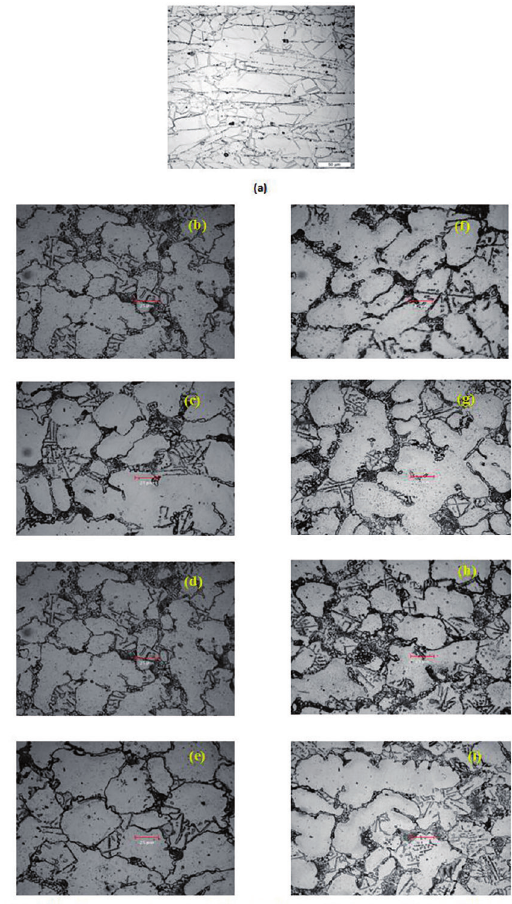
Figure 5. Microstructure images of (a) Base matrix alloy, (b) 3% Garnet with chill, (c) 3% Garnet with No chill, (d) 6% Garnet with chill, (e) 6% Garnet with No chill, (f) 9% Garnet with chill, (g) 9% Garnet with No chill, (h) 12% Garnet with chill, (i) 12% Garnet with No